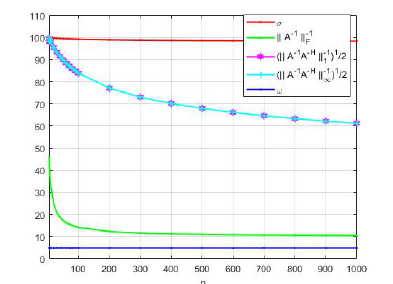
Figure 3: a 1 , a 2 , a 3 , a 4 = 10/3, 1/3, 2/3, 5/3 [i=4].